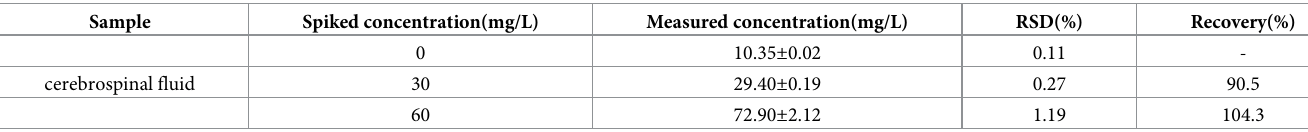
Table 1. Spectrophotometric determination of Trp in pool specimens (n =